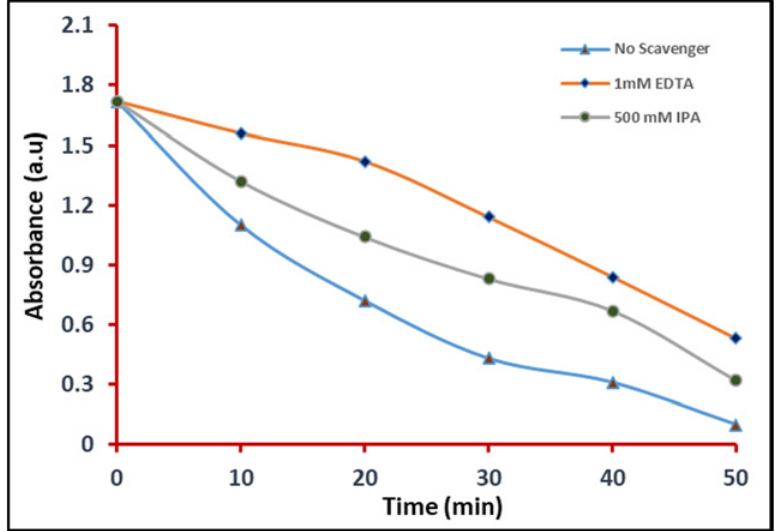
Fig. 11. Scavenger experiment for photocatalytic degradation of Nigrosine dye by using MgZrO